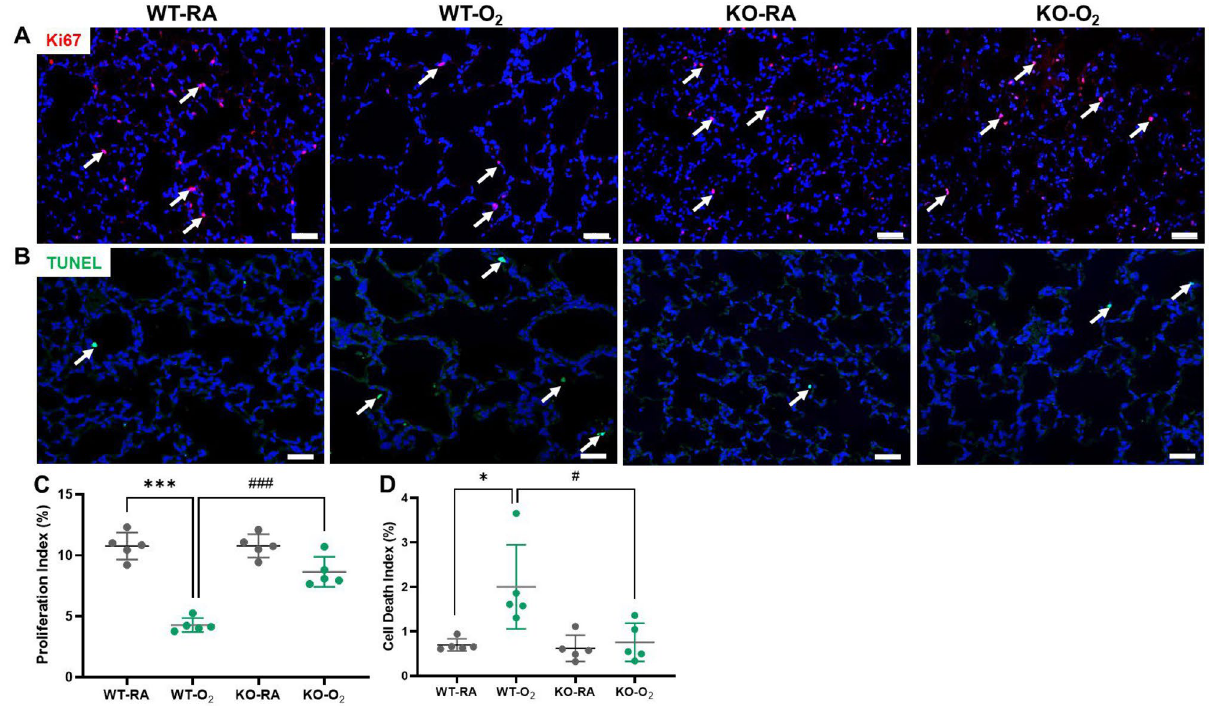
Figure 4. GSDMD-KO improves cell survival in hyperoxia-exposed lungs. ( A ) Immunofluorescent staining for Ki67 (pink signals, white arrows) and DAPI staining (blue signals) were performed to assess cell proliferation. ( C ) Quantification of the cell proliferation index (percentage of Ki67 positive nuclei divided by total nuclei) revealed that hyperoxia decreased cell proliferation in WT lungs but GSDMD-KO improved cell proliferation in hyperoxia-exposed lungs. ( B ) TUNEL Assay (green signals, white arrows) and DAPI nuclear stain (blue signals) were used to identify dead cells. ( D ) Quantification of cell death (percentage of apoptotic nuclei divided by total nuclei) revealed that WT lungs had increased cell death when exposed to hyperoxia. In contrast, hyperoxia- exposed KO lungs had significantly less cell death. n = 5/group. * P < 0.05, *** P < 0.001, WT-RA vs WT-O